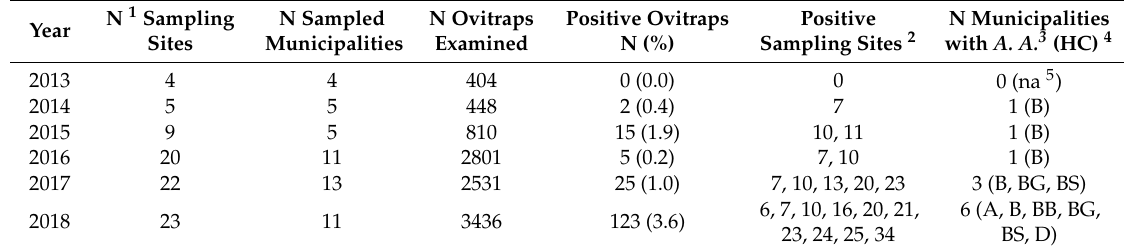
Table 2. Summary of sampling details and results on the presence of Aedes albopictus eggs in the ovitraps over the study years and